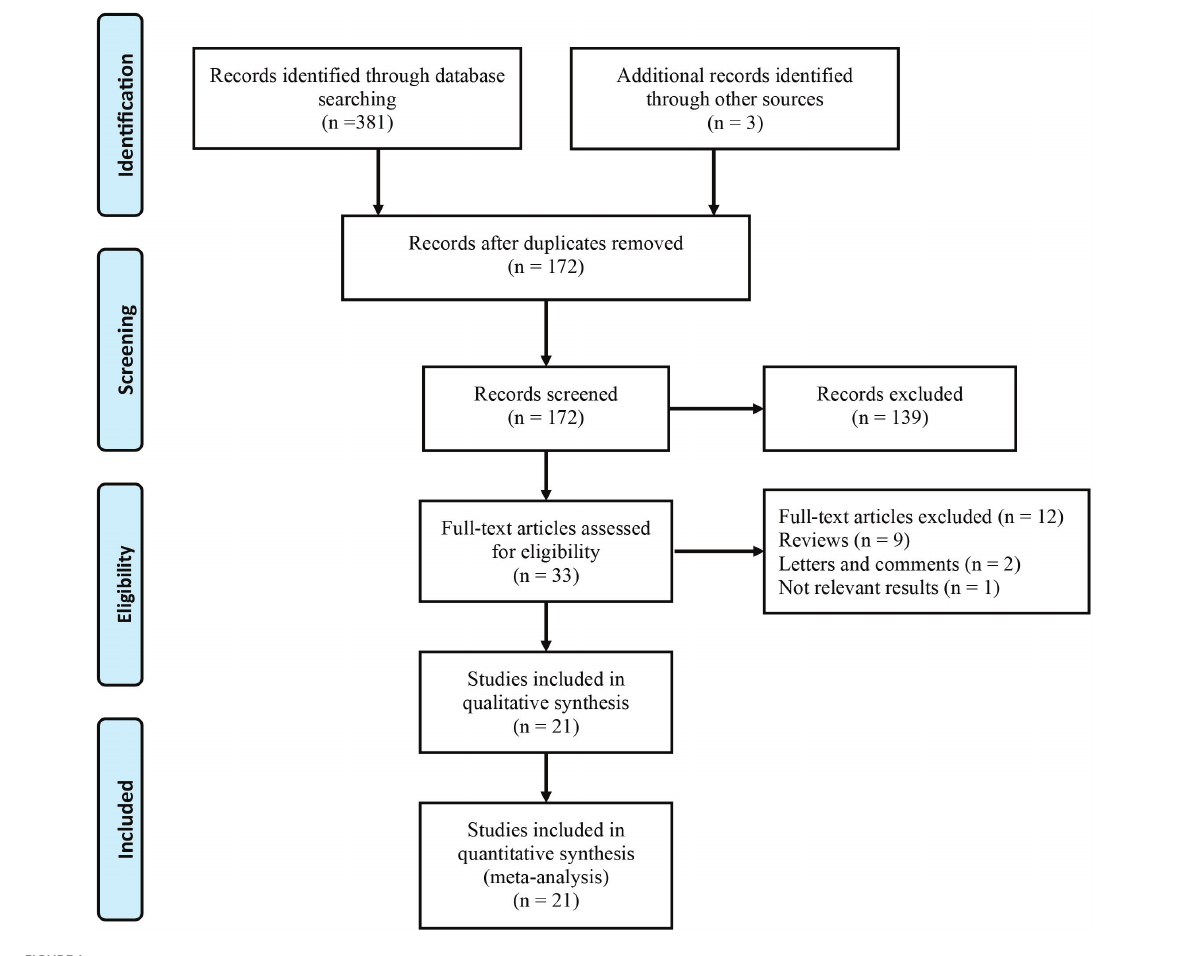
FIGURE1 Flow diagram of the study selection process.